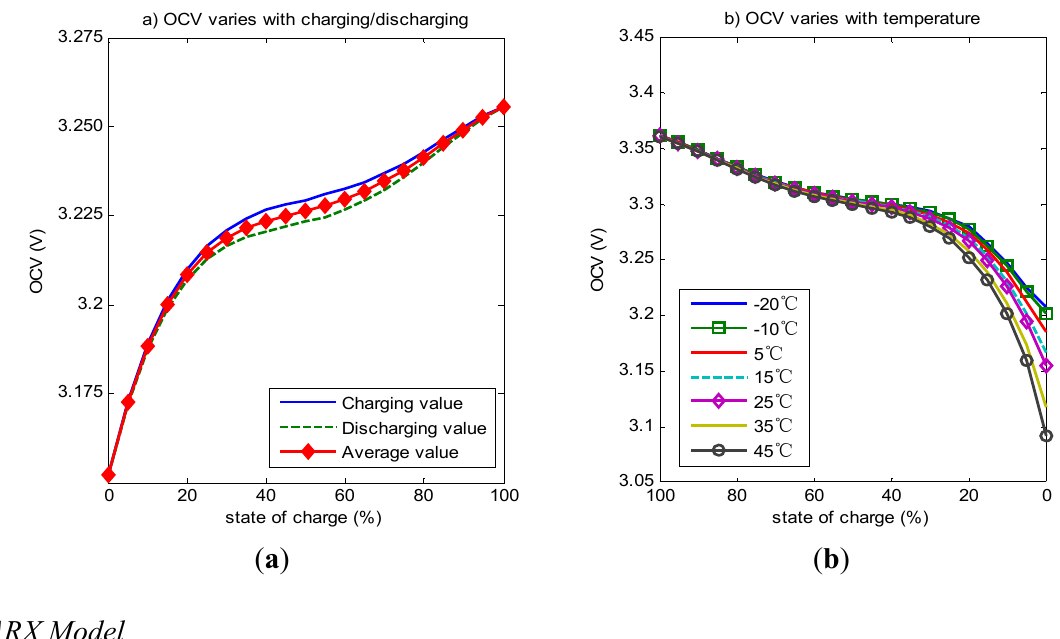
Figure 9. Open-circuit voltage versus state of charge (SOC). ( a ) OCV varies with charging/discharging; ( b ) OCV varies with